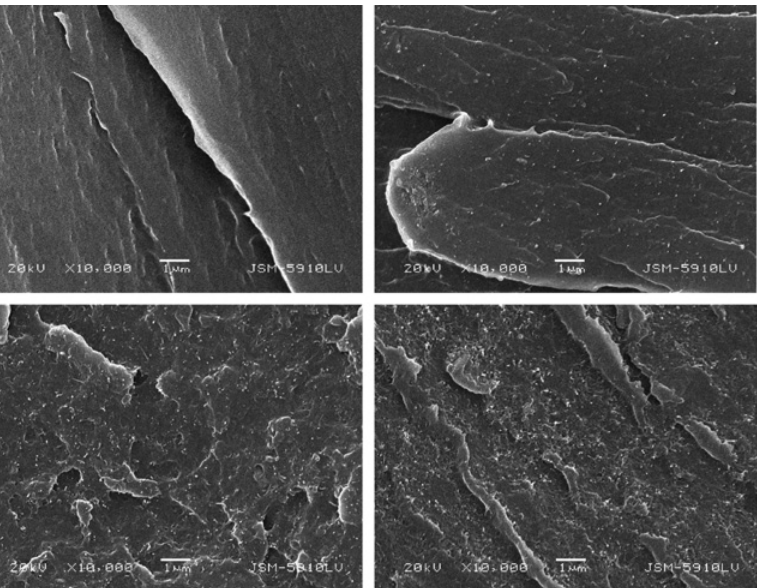
Figure 3 SEM micrographs of microstructures. Neat PC (upper left), C1 specimen (upper right), C3 specimen (lower left), and C5 specimen (lower